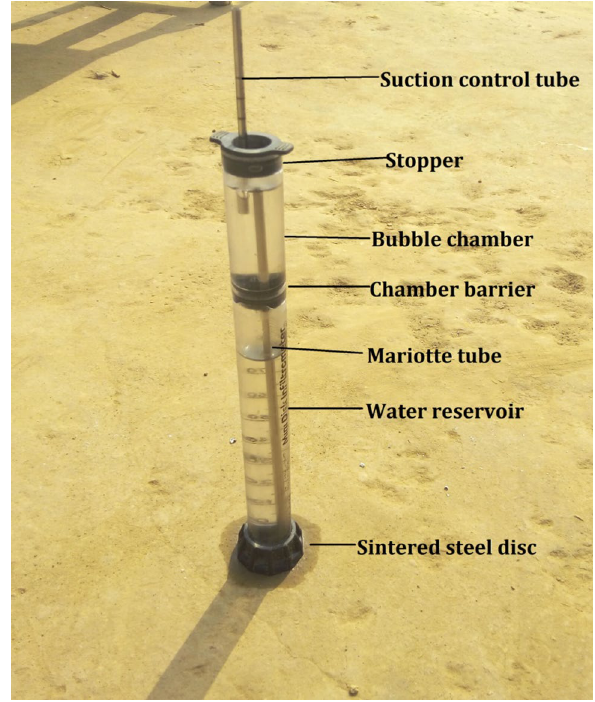
Fig. 1 Mini disk infiltrometer (Infiltrometer User’s Manual